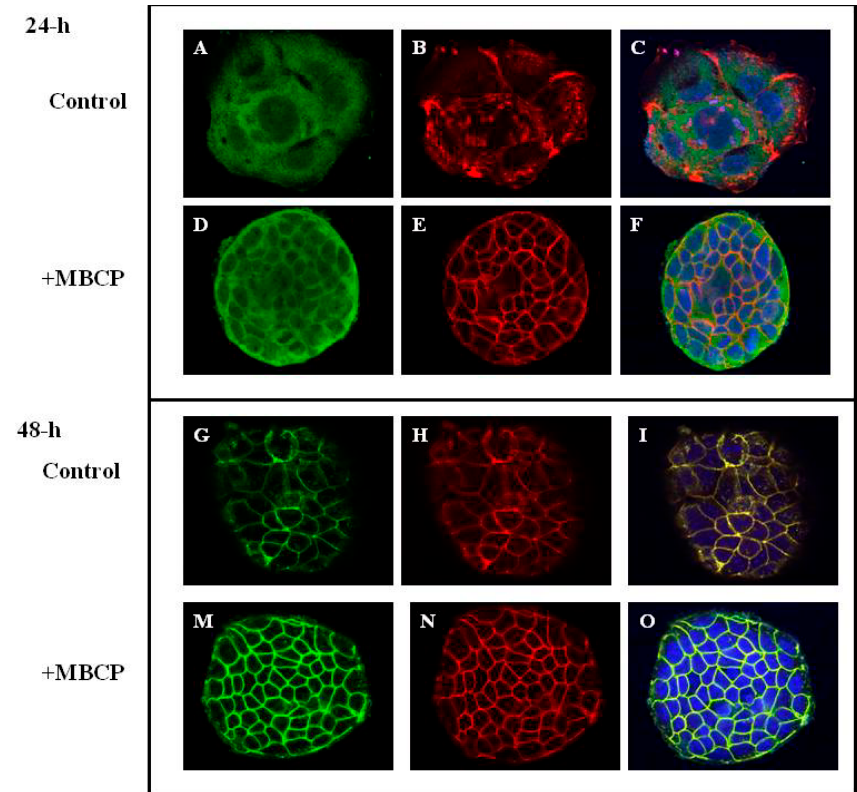
Figure 2. MBCP accelerates the formation of adherens junctions. Confocal microscopy images of Caco-2 cells ( A – C , G – I ) and MBCP treated Caco-2 cells (panel ( D – F , M – O ). Cells were treated for 24-h and 48-h with MBCP at 18 μ M concentration. The merged image is on the right (green, actin; red, E-cadherin; blue, dapi).